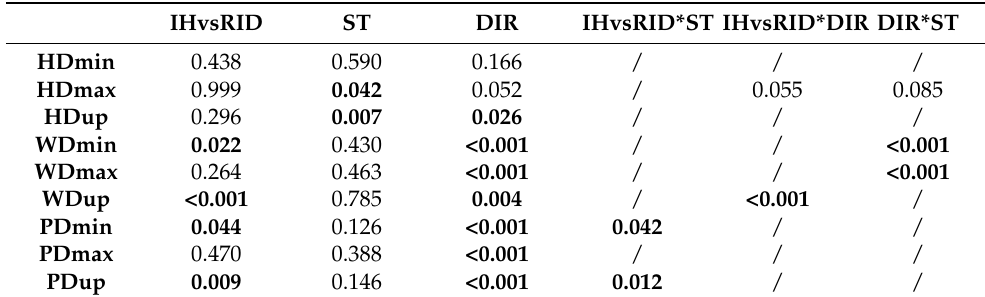
Table 2. Overview of the results of the mixed model investigating the effect of in-hand versus ridden exercise (IHvsRID), of stride time (ST) and of movement direction (DIR). Presented are p -values for single factors IHvsRID, DIR and ST and their interactions (where relevant for each of the reduced models). Significant p -values ( p < 0.05) in bold.